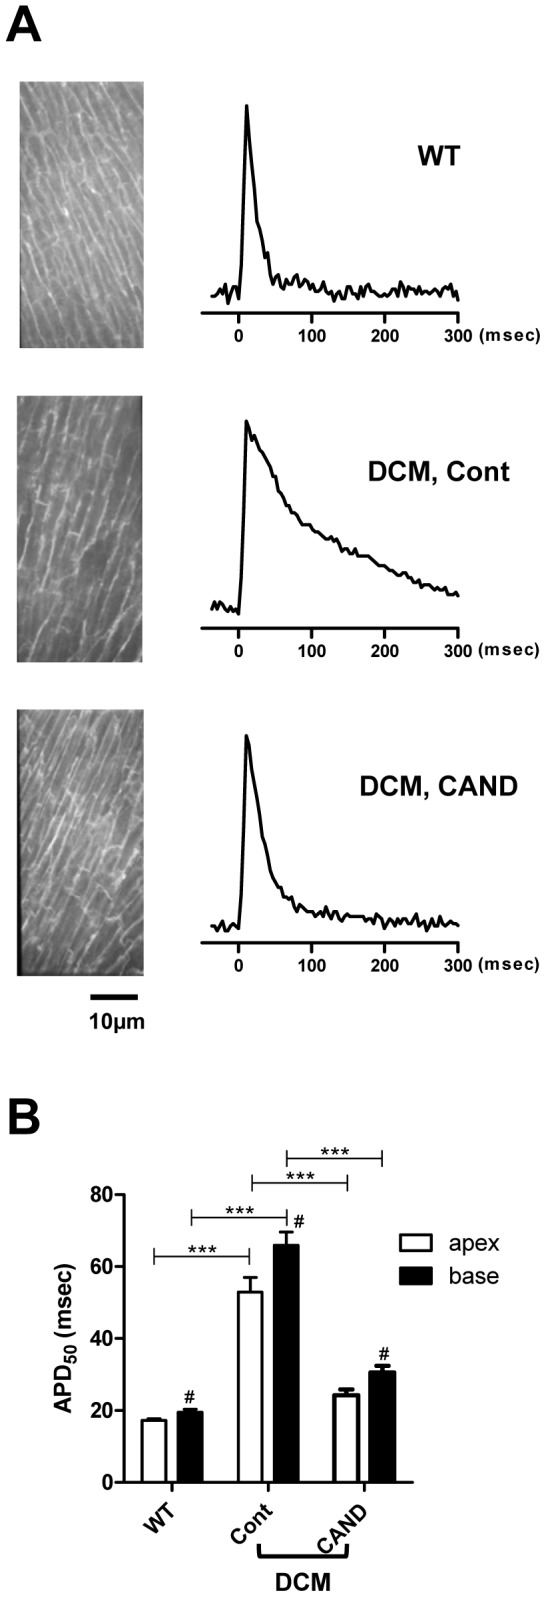
AP signals obtained from WT and DCM LVs.
A. Representative AP signals recorded from the basal region of LVs of WT (top), control DCM (middle) and candesartan-treated DCM (bottom) mice stimulated at 0.5 Hz. B. Comparison of APD50 values in the basal and apical regions of LVs from WT (base: n = 10, apex: n = 12 from five hearts) control DCM (base: n = 31, apex: n = 35 from 6 hearts) and candesartan-treated DCM (base: n = 25, apex: n = 21 from four hearts) mice. ***P<0.001, #P<0.05 vs the apex in the same group.